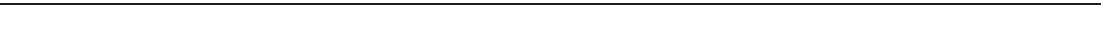
Fig. 7 Phase I clinical trial of docetaxel and SMO inhibitor, NVP-LDE225 (EDALINE) in patients with advanced TNBC. a Representative computed tomography (CT) images from a patient with complete radiological response. The 54-year-old postmenopausal woman was diagnosed with recurrent metastatic TNBC in the lungs with one measurable lesion on the right upper lobe (red arrow) and several nonmeasurable lesions (blue arrows). Therapeutic response was evaluated according to RECIST criteria version 1.1. The remaining structure seen in the right upper lobe corresponds to the azygos vein (violet arrow). b Representative HH and GLI1 immunostaining of treatment-naive tumor specimens from patients enrolled in the EDALINE trial. The left panel is representative of patients with high HPAS (characterized by high epithelial HH ligand and high stromal GLI1 expression) while the right panel represents low/intermediate epithelial HH and low stromal GLI1 expression. Scale bars: 100 μ m. c Representative immunohistochemistry staining for phospho-FGFR, collagen deposition depicted by SHG imaging and concomitant phospho-FAK and ALDH1 stem cell marker expression in